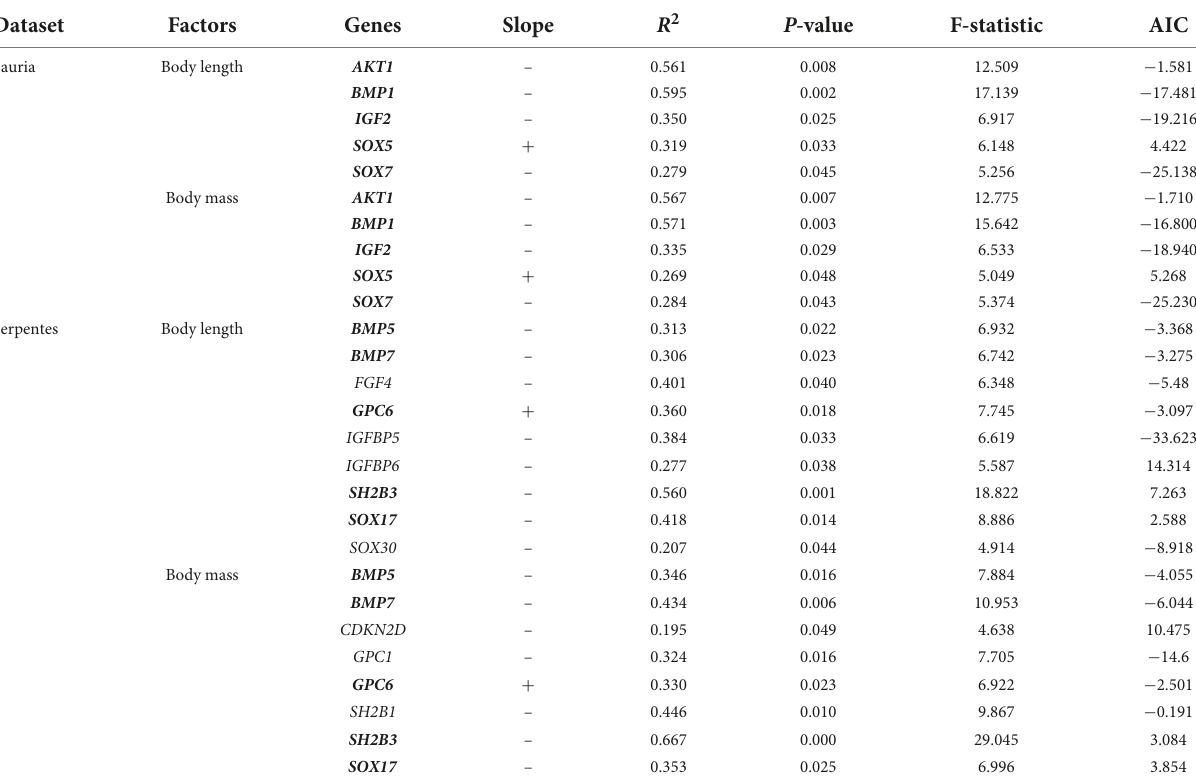
TABLE 4 Association analyses between gene evolution and phenotypes in lizards and snakes (genes significantly associated with body length and body mass are boldfaced).